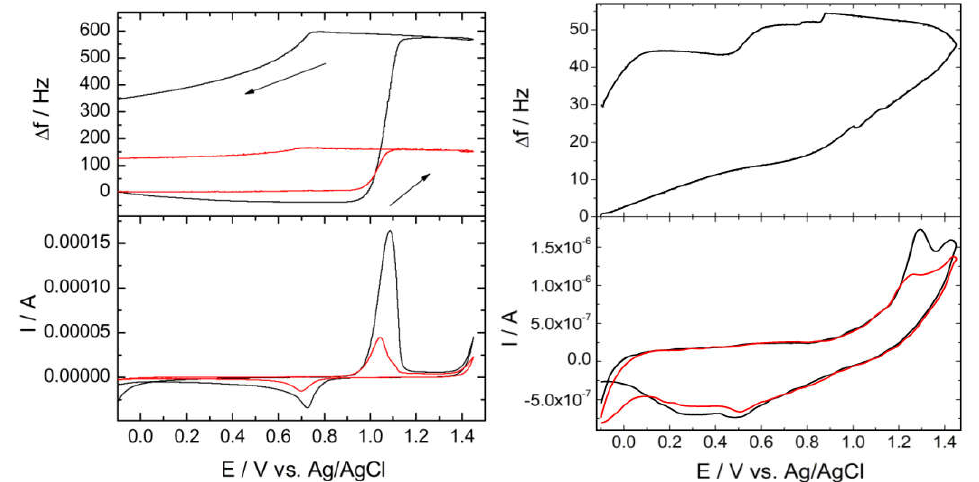
Figure 5. Left: EQCM profiles for Ti/Au/TiO 2 electrodes in the ethanol extract, recorded in 0.1 M NaNO 3 , v = 0.01 V s − 1 . The black line is the profile for the Erythrina crista-galli extract, and the red line is for the supporting electrolyte. Right: Voltametric and frequency profiles for phycoerythrin solutions in the supporting electrolyte, for samples extracted from Delesseria lancifolia (black line), and for the supporting electrolyte 0.1 M NaNO 3 (red line). Reference electrode Ag/AgCl (0.195 V vs. NHE).